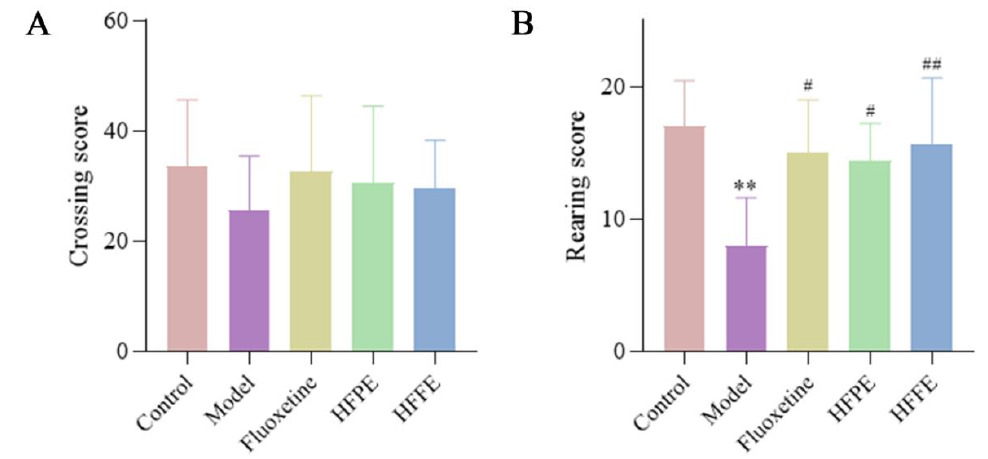
Figure 6. Effects of HFPE and HFFE on OFT test. ( A ) represents crossing score, ( B ) represents rearing score. Results were represented as mean ± SD ( n = 10). ** p < 0.01 compared with the control group, # p < 0.05 and ## p < 0.01 compared with the model group.